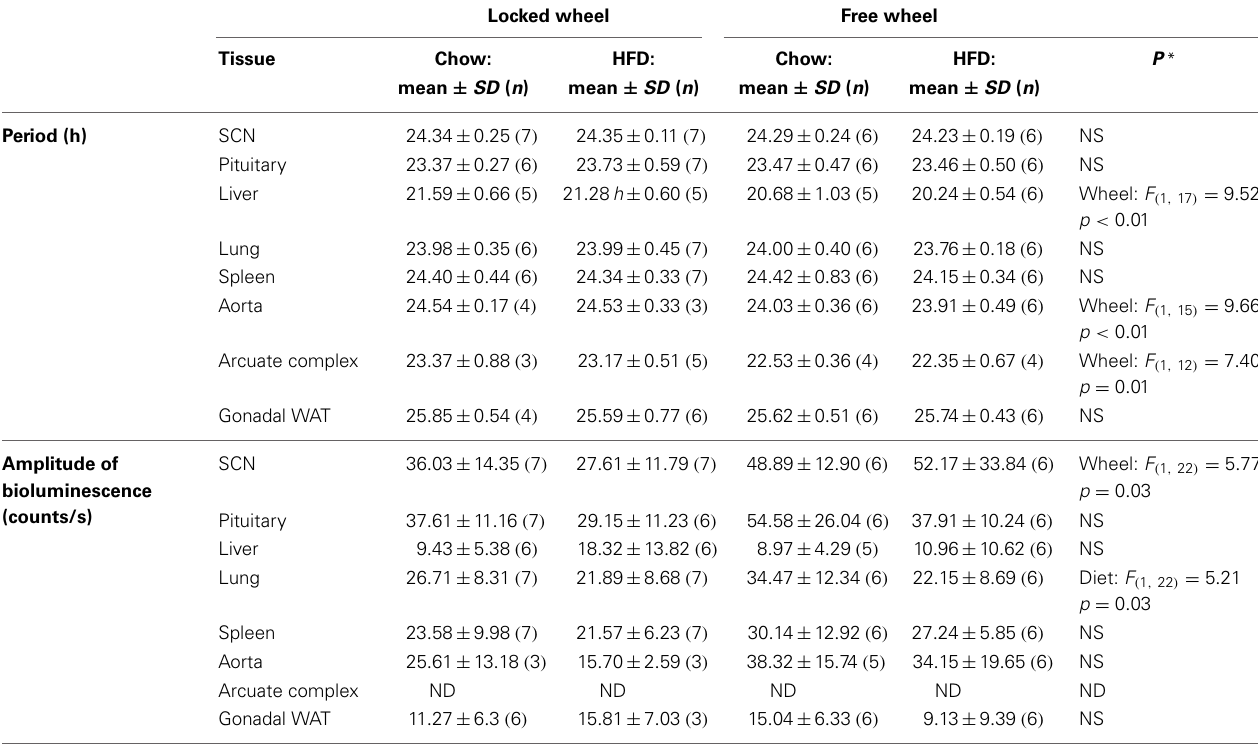
Table 1 | Circadian parameters of bioluminescence rhythms in ex vivo